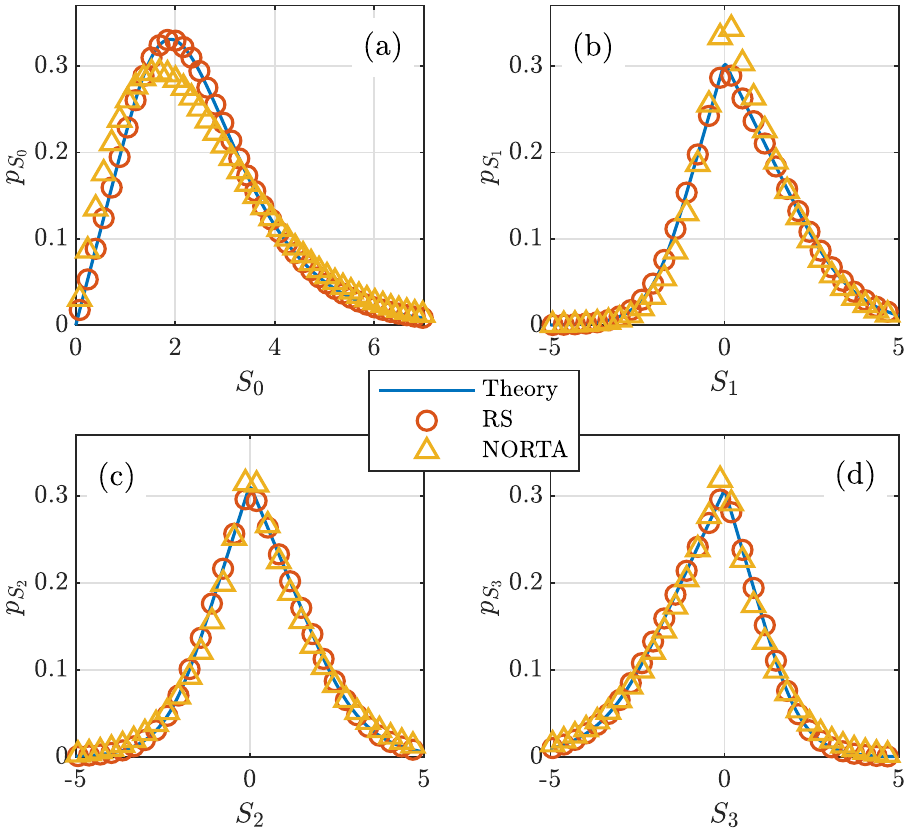
Figure 6. Stokes parameter PDFs: ( a ) p S